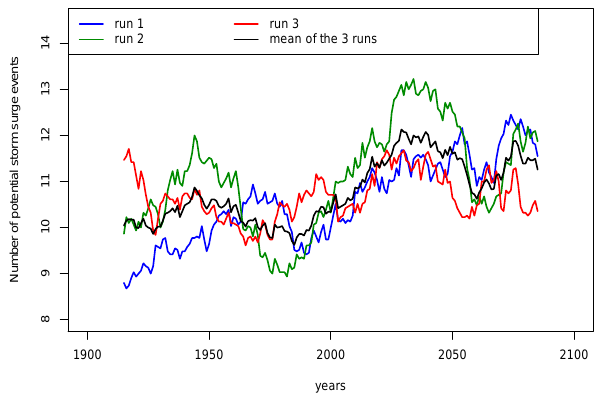
Figure 5. 30 year running mean of the annual number of potential storm surge events from 1915 to 2085 for the three runs (run 1: blue, run 2: green, run 3: red) and for the mean of all ensemble members